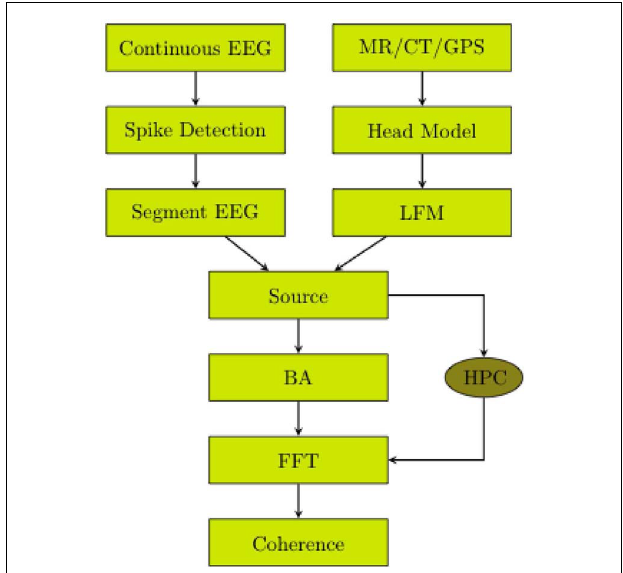
FIGURE 1 | EEG was continuously recorded . Spikes were detected.The continuous EEG was segmented.The head volume (MR/CT) was segmented and registered to the electrodes.The lead field matrix was calculated.The cortical source waveforms were estimated.The source waveforms were averaged over Brodmann Areas.The BA waveforms were transformed to the frequency domain by fast Fourier transformation.The coherences of the BA waveforms were computed. If the high performance computing (HPC) power is available, the step of averaging over BAs is not